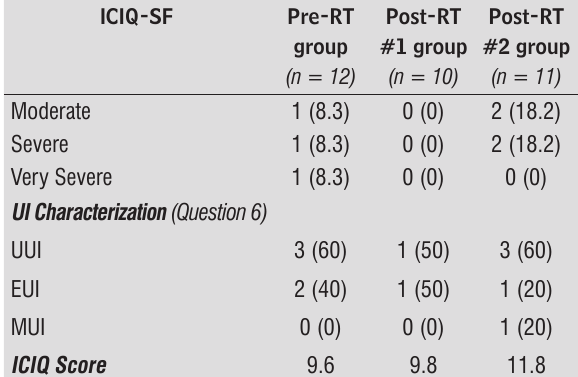
Table 4 - Urinary incontinence and its impact on daily